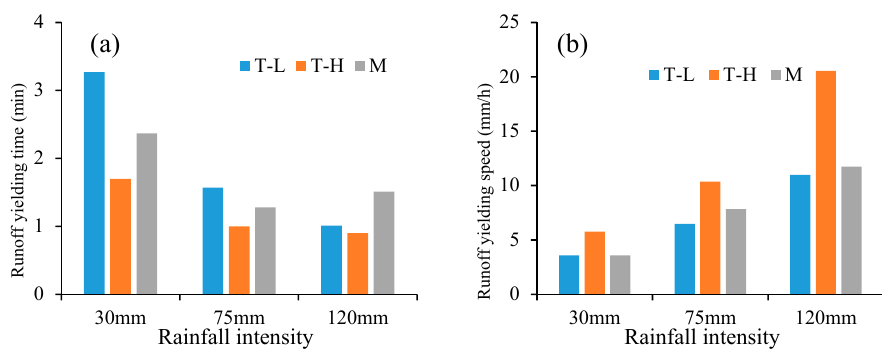
Figure 5. Runoff yielding time ( a ) and rate ( b ) at different sites. T-L stands for thin litter layer with low soil bulk density, T-H stands for thick litter layer with high soil bulk density, and M stands for moderate litter depth and soil bulk density.